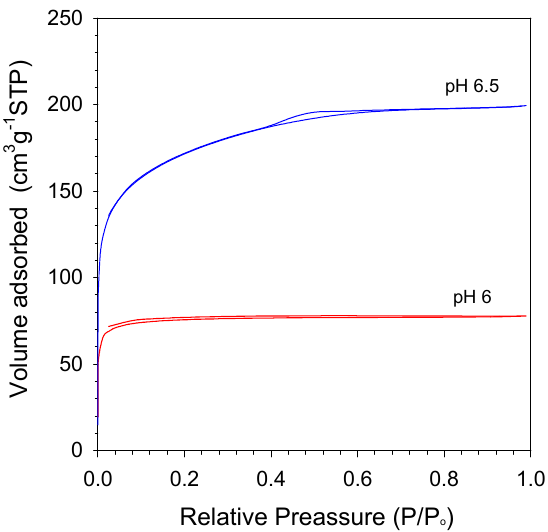
Figure 7. N 2 physisorption isotherms of organo-silica xerogels at varied pH. Table 4. Surface properties of organo-silica xerogels at varied